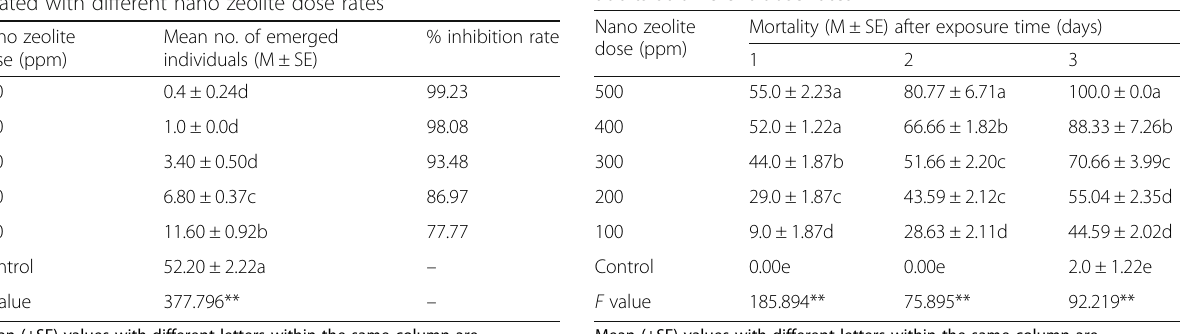
Table 4 Effect of nano zeolite (40 – 45 nm) against C.